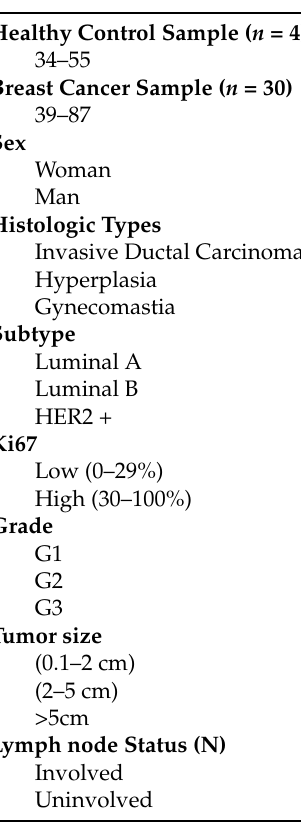
Table 1. Clinico-pathological characteristics of the study